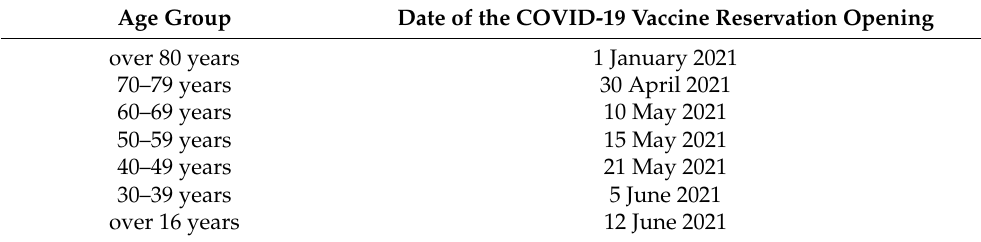
Table 1. Date of the COVID-19 vaccine reservation opening for each age group in